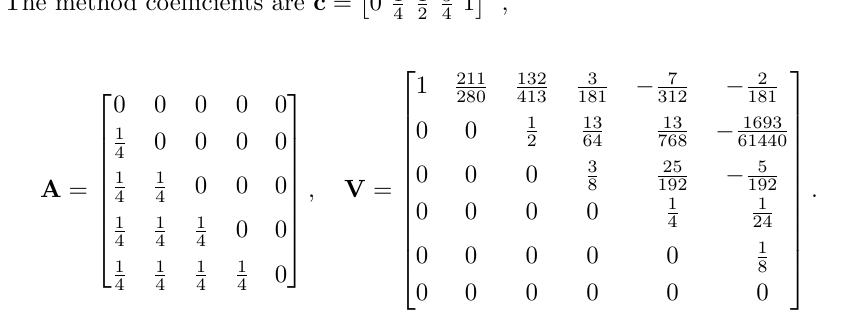
The method coefficients are c